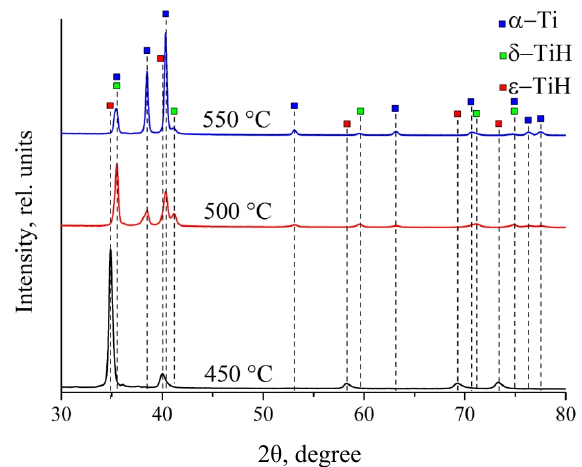
Figure 7. Diffraction patterns of the 80 µm Ti coating after hydrogenation at various temperatures. Figure 7. Di ff raction patterns of the 80 µ m Ti coating after hydrogenation at various Table 4. Structural parameters of the 80 µm Ti coating after hydrogenation.